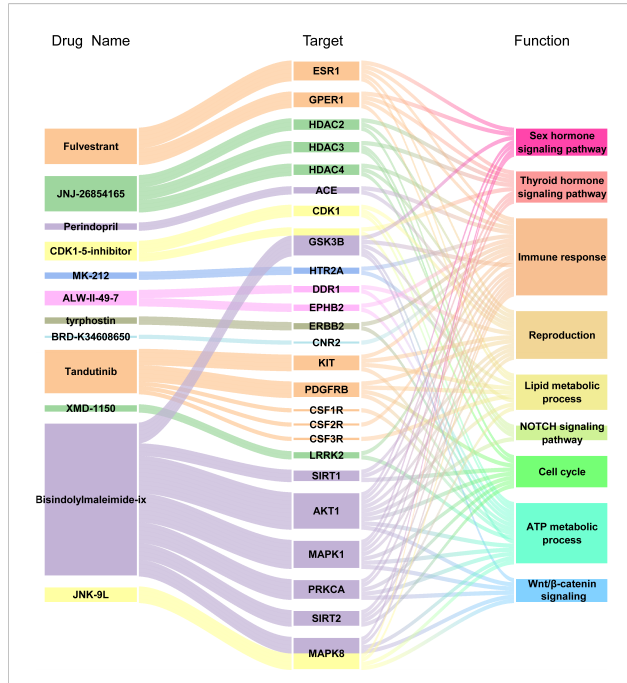
FIGURE 8 Drug-Target genes Interaction Network Analysis. From the left to right of alluvial diagram: the potential pharmaceuticals, target genes and enriched pathways by GO and KEGG analysis.